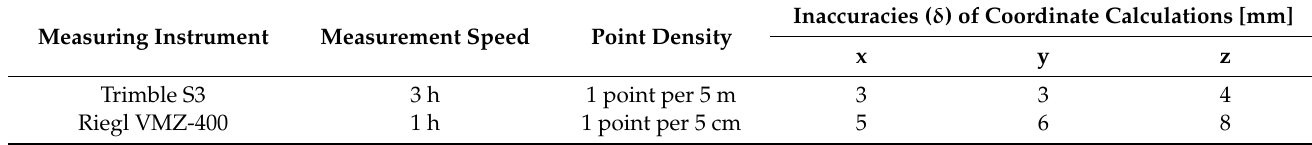
Table 2. Measurement accuracies with respect to the control